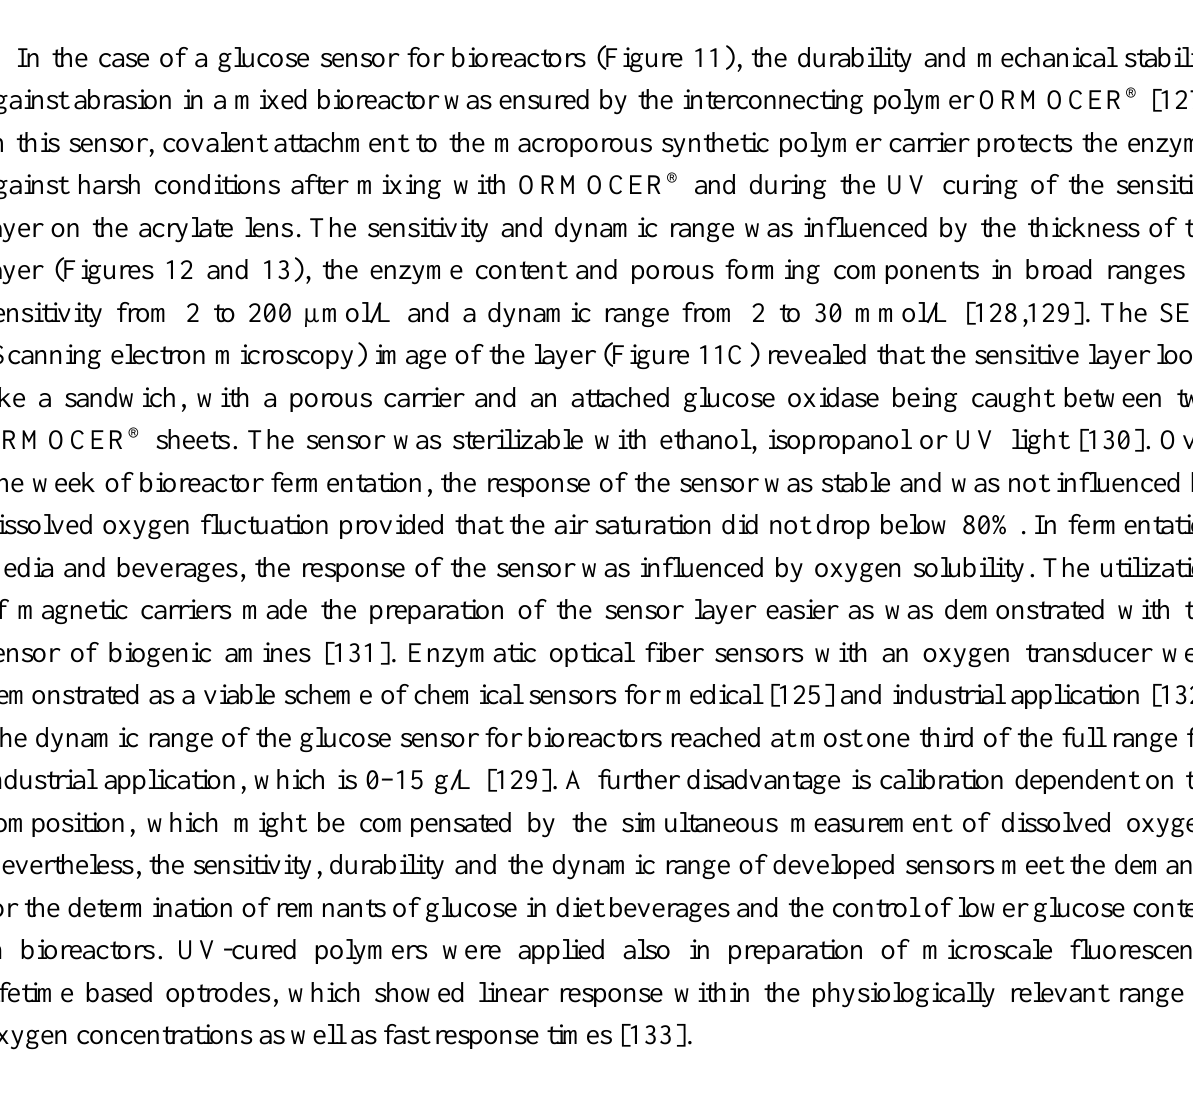
Figure 11. A bioreactor equipped with oxygen and glucose optical fiber probe ( A ) optical fiber probe; ( B ) SEM of the recognition layer composed from ORMOCER ® with a ruthenium complex ( C